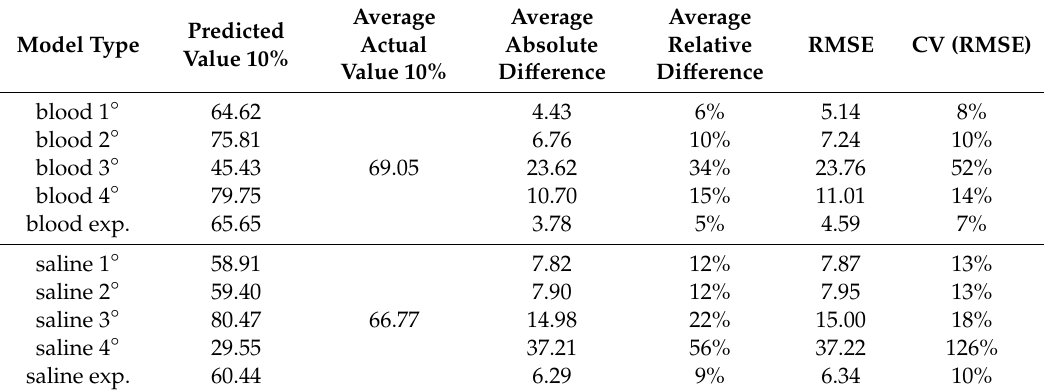
Table 3. Prediction accuracy of selected models for the case with 10% admixture from the 0–8% model.